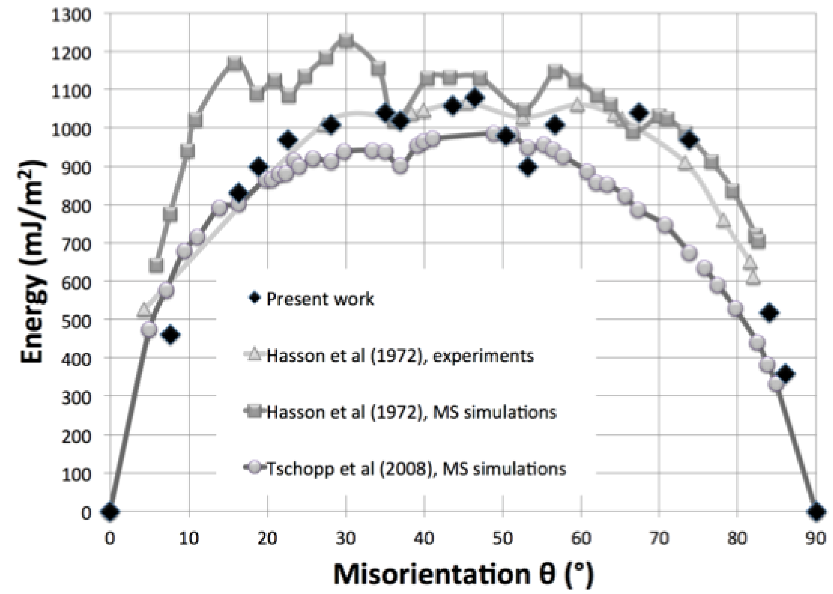
Figure 3. Excess energy of <001> tilt grain boundaries in copper bi-crystals. Black diamonds: present work; Gray triangles/squares: experimental measurements/molecular statics predictions [65]; Gray circles: molecular statics predictions